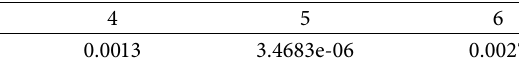
Table 3: Test error result of the rectangular MSA.